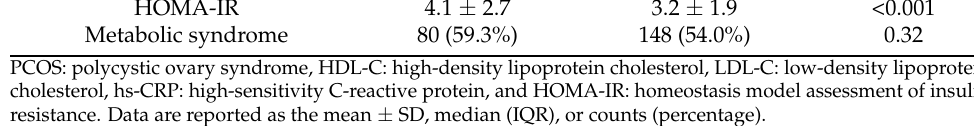
A comparison of the diet, eating behavior, physical activity, and QoL between the PCOS group and the non-PCOS group is shown in Table 2. Women with PCOS had an intake of 107 (78.6; 157) gram vegetables per day, which was significantly less than non-PCOS women (129 (85.7; 179) gram). However, after adjusting for age, waist–hip circumference ratio, and HOMA-IR, the statistically significant difference disappeared (mean difference: − 8.31 g, 95% CI: − 25.0 to 8.36, p = 0.33). The analyses adjusting for age, waist–hip circumference ratio, and HOMA-IR one at a time (Supplementary Table S1) showed that the change of the mean difference was mainly driven by age. No statistically significant differences in the intake of fruits, sugary drinks, alcoholic beverages, savory snacks, and sweet snacks were observed between the two groups. The overall score of emotional eating was 34.6 ± 11.2 in the PCOS group and 34.1 ± 11.3 in the non-PCOS group (mean difference: 2.03, 95% CI: − 0.45 to 4.51, p = 0.11). The overall scores of external eating and restricted eating in both groups were not statistically significantly different. No statistically significant differences in the total moderate-to-vigorous physical activity were observed between the groups, as well as the proportion of leisure time moderate-to- vigorous physical activity (yes/no) or commuting moderate-to-vigorous physical activity